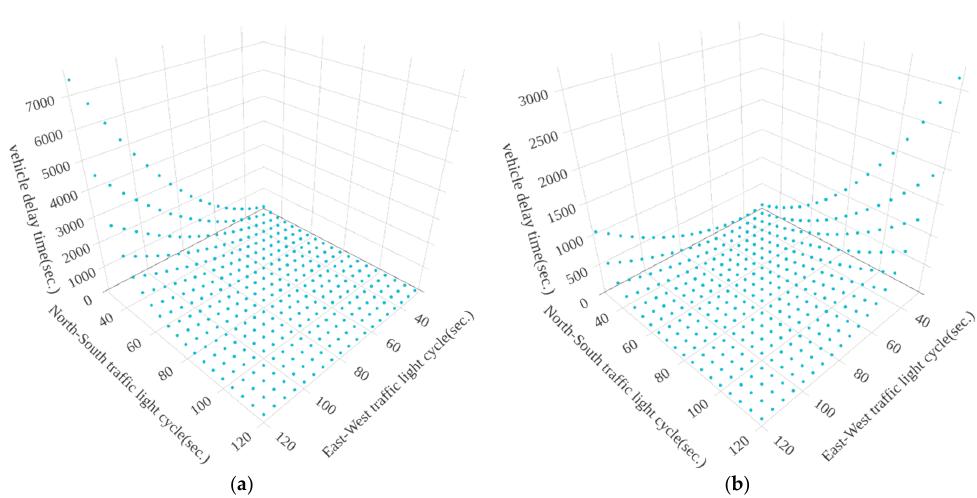
Figure 10. The results of vehicle delay by using exhaustive search method on Huanhe N. Rd. and Minsheng W. Rd. ( a ) from 8:00 a.m. to 9:00 a.m. ( b ) from 5:00 p.m. to 6:00 p.m.